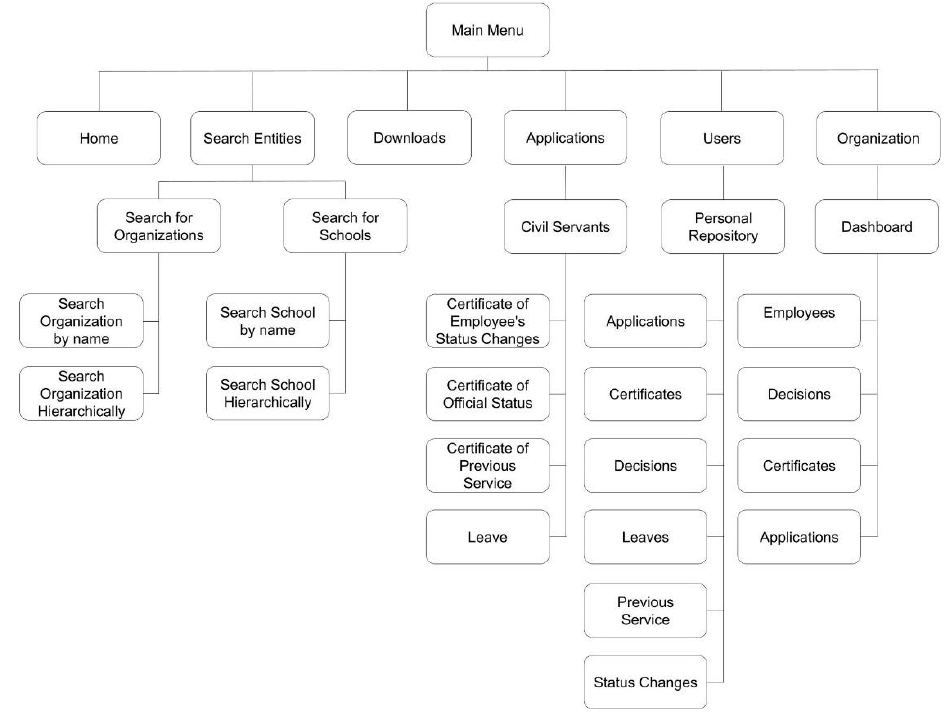
Figure 5. The services offered by the web portal.